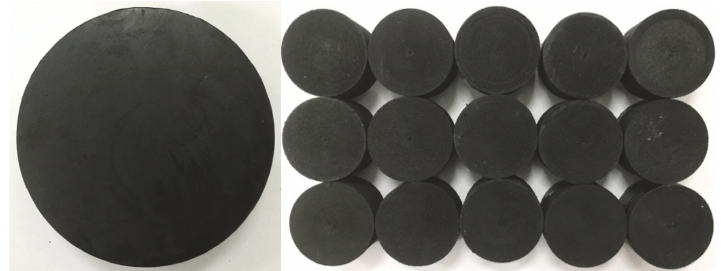
Figure 6: The preparative samples of high-damping rubber.